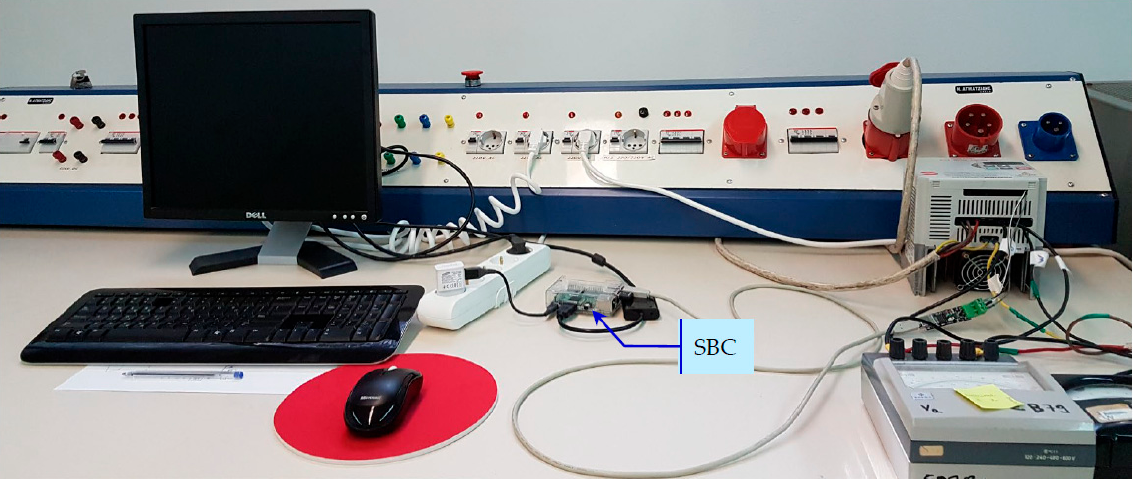
Figure 3. Experimental System (from left to right): Central control panel, SBC, monitor, keyboard, mouse, inverter, Induction Motor, dc generator, single-phase recti fi er, speed optical encoder, SBM1, SBM2, optical isolation unit, electric load, measuring instrumentation.